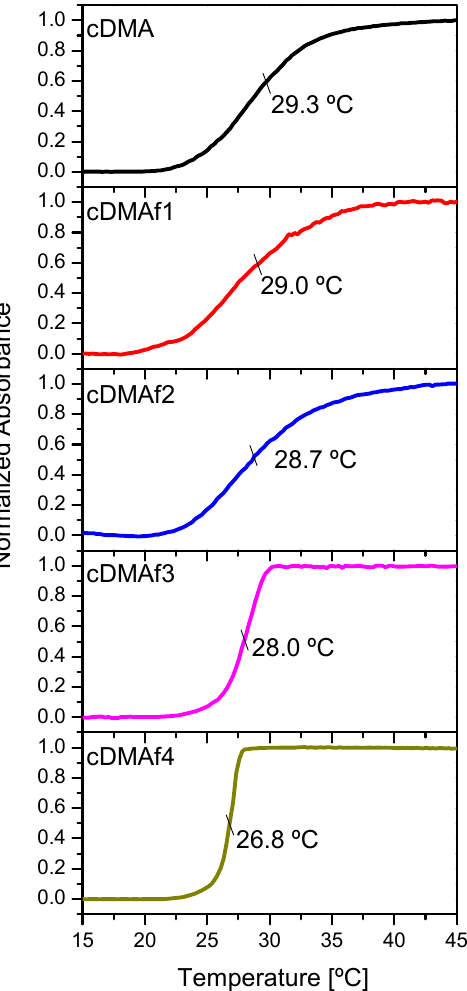
Figure 3. Phase transition temperatures, analyzed by UV–vis spectroscopy for all polymeric solutions (4 wt.%).